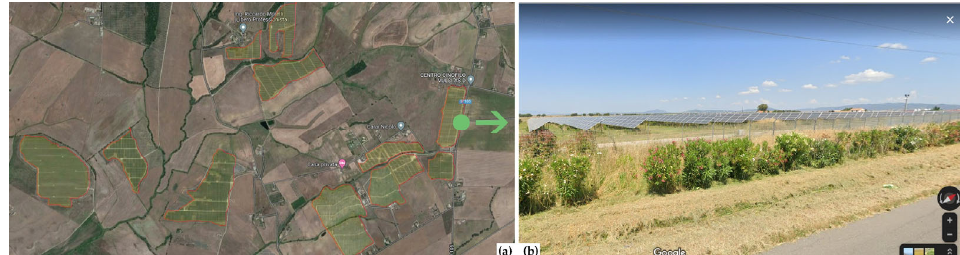
Figure 3. Example of the Agrivoltaic practices in Montalto di Castro Municipality, Viterbo Province, Lazio Region, Italy. ( a ) shows the distribution of the PV panels on the agricultural lands as multi- function land uses (Map imagery © 2022/Airbus, European Space Imaging, Landsat/Copernicus, Maxar Technologies, Map data © 2022, Google); ( b ) depicts an example of the installation (SP105 Lazio Google Street View—Jun 2019 © 2022, Google).